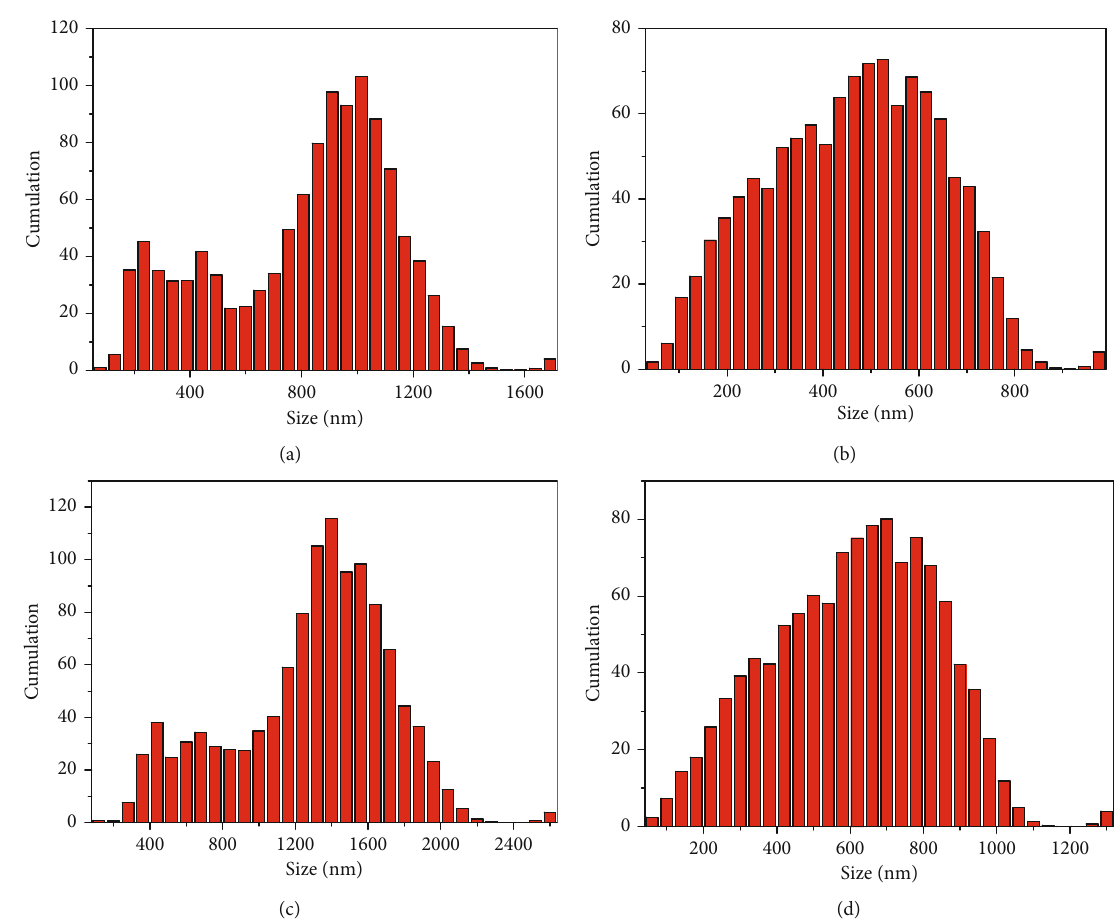
Figure 7: Size distribution histograms of (a) Blank-, (b) MEA-, (c) DEA-, and (d) TEA-CeO